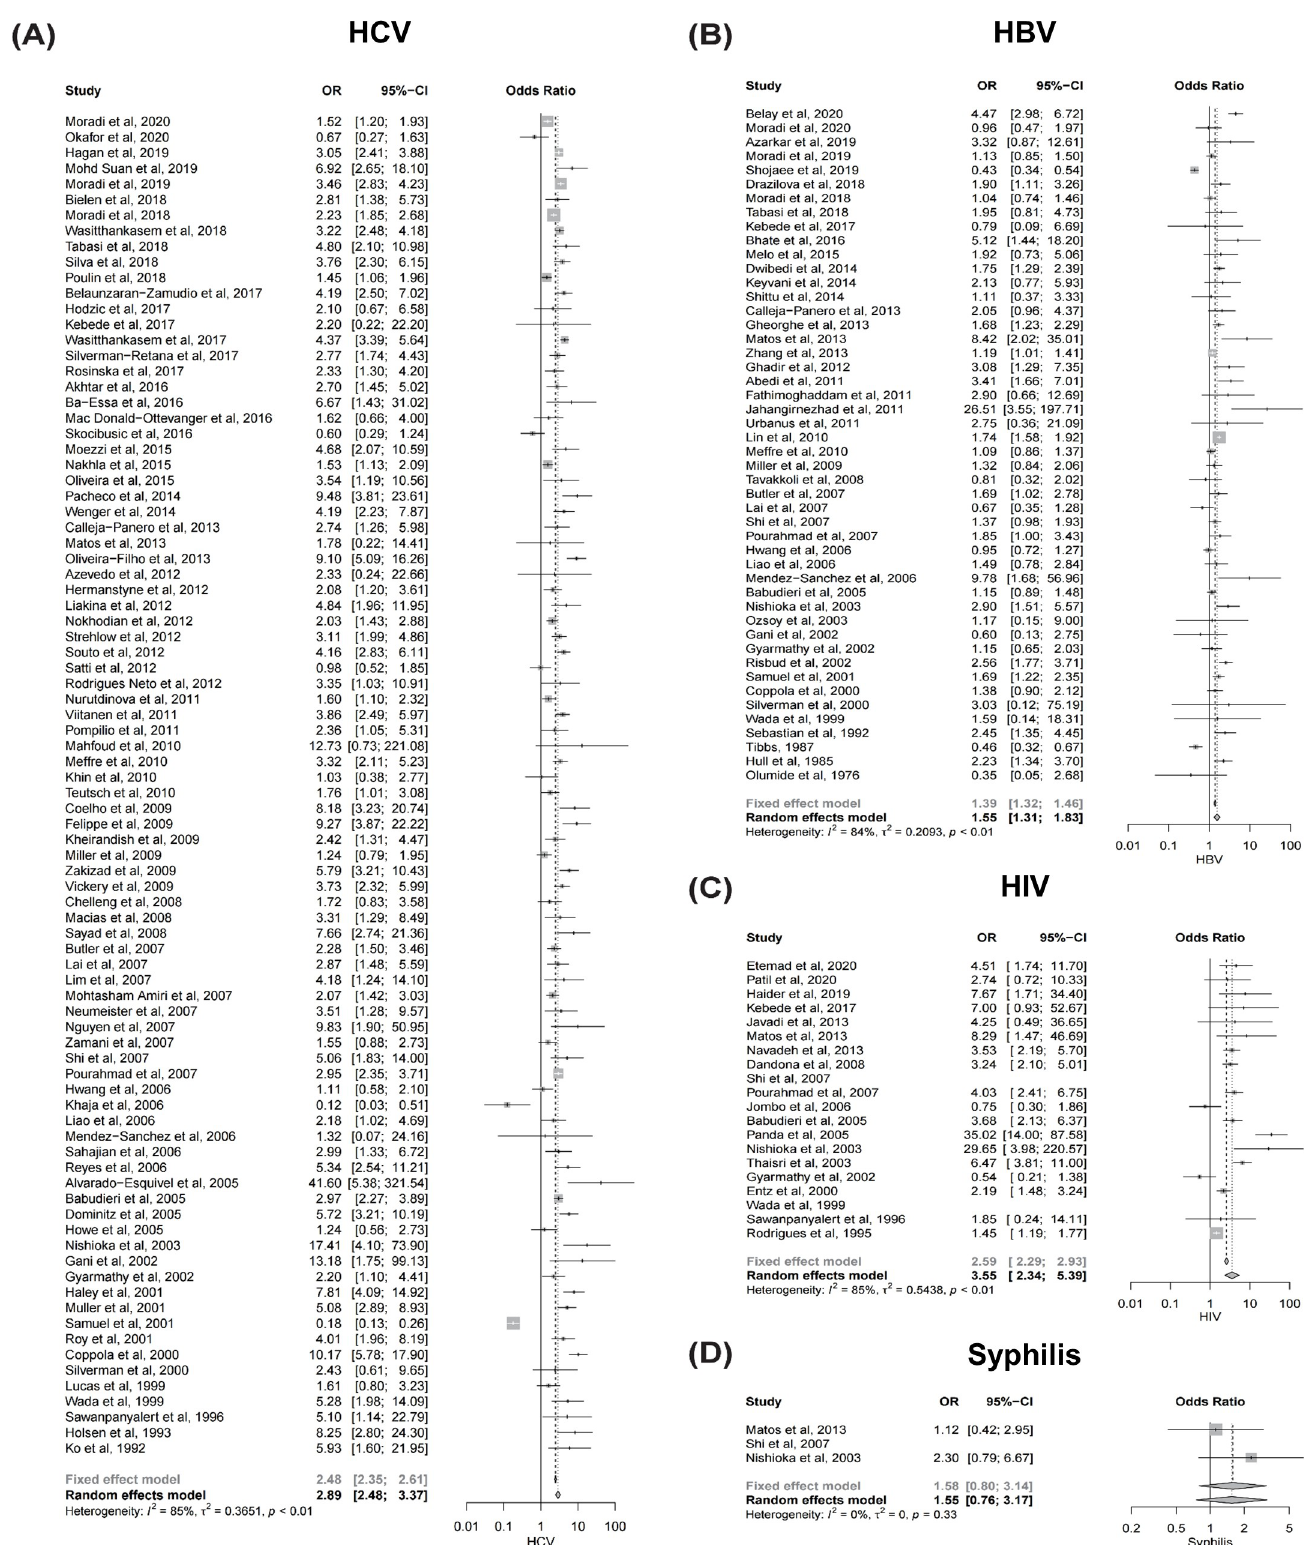
Fig 2. Forest plots summarizing the meta-analysis. Forest plots of the meta-analysis. (A) HCV, (B) HBV, (C) HIV, and (D) Syphilis. Abbreviations: HCV, hepatitis C virus; HBV, hepatitis B virus; HIV, human immunodeficiency virus.